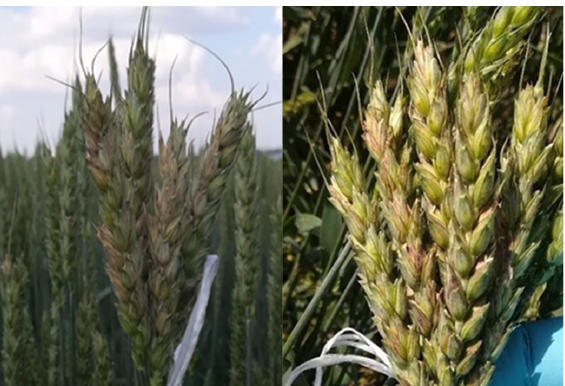
Figure 3. Spring wheat heads with signs of Fusarium head blight infection caused by F. avenaceum (on the left ) and F. graminearum (on the right ).